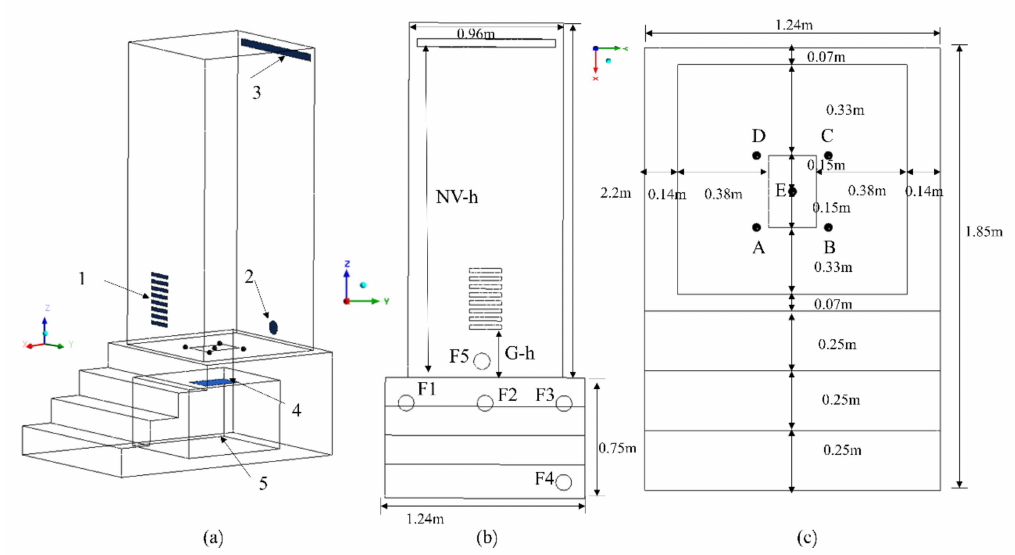
Figure 3. Schematic of the experimental chamber and location of sampling points. Points F1 (0,0.13,0.59), F2 (0,0.62,0.59), F3 (0,1.11,0.59), F4 (0,1.11,0.1), F5 (0.07,0.62,0.85), unit: m. 1—Grid, 2—Fan, 3—Window, 4—Pollution source, 5—Fermentation tank, ( a ) Model diagram; ( b ) Front view; ( c ) Top